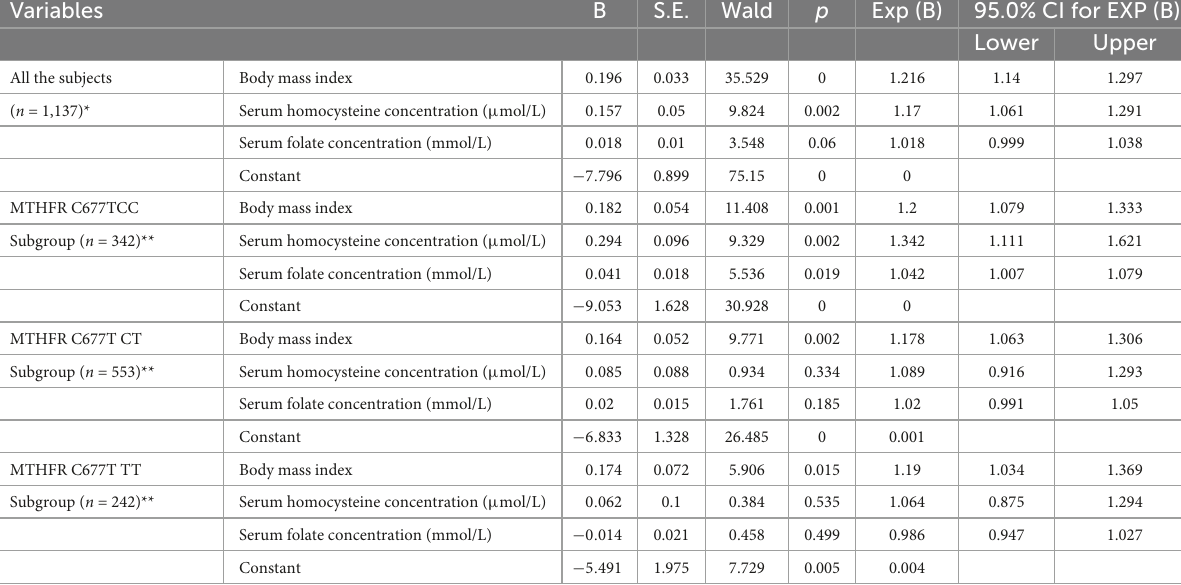
TABLE 3 Establishment and internal validation of prediction model for pregnancy induced hypertension based on logistic linear regression analysis ( n = 1,137).